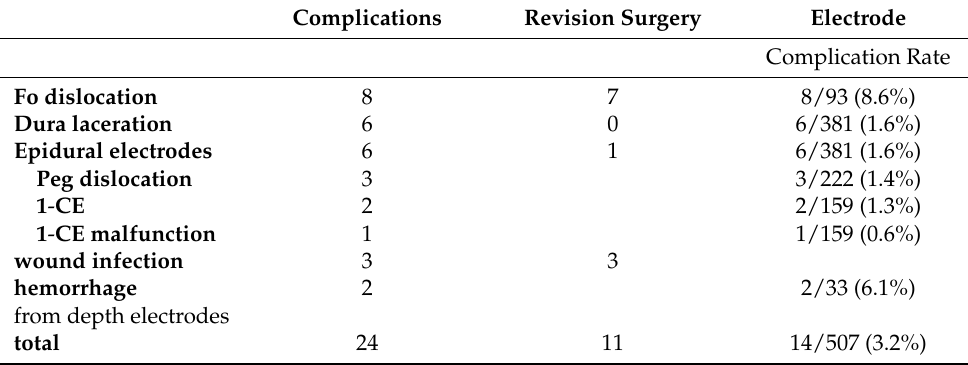
Table 3. Overview of